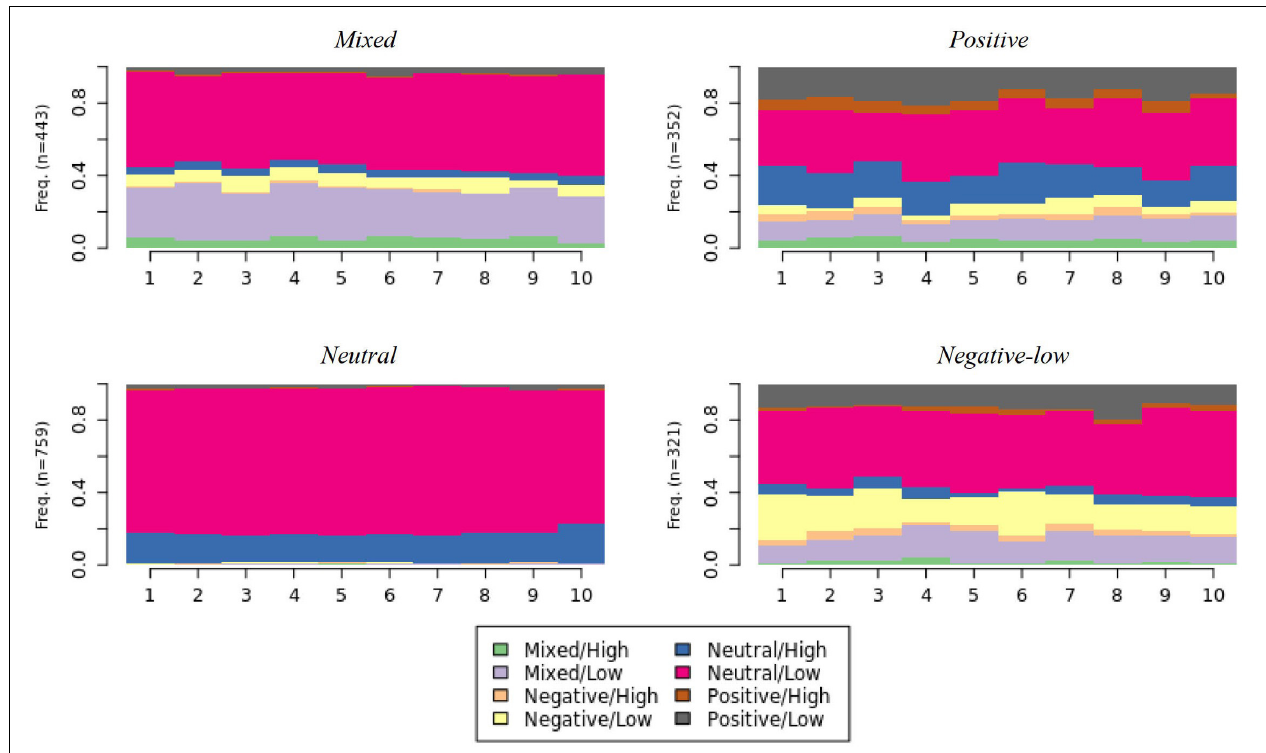
FIGURE 3 | Index plots depicting the valence of participation and emotional activation characteristics for the four clusters of socio-emotional states.